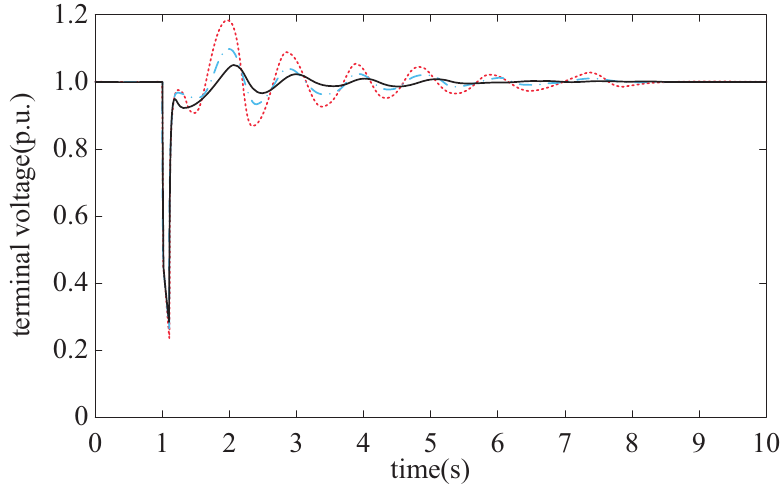
Figure 3. Response of the terminal voltage of generator under a circuit